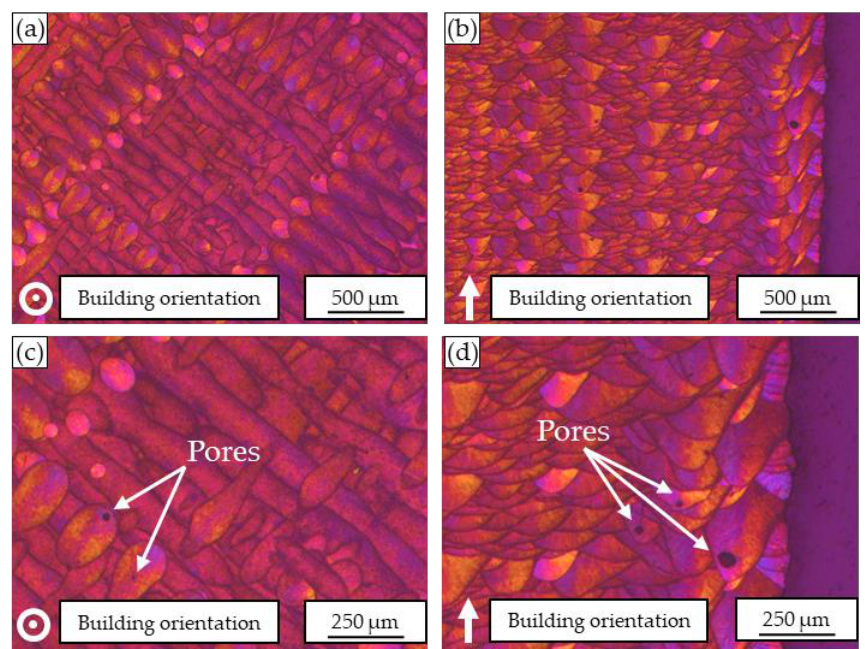
Figure 2. Barker etched microstructure of the horizontal 0° specimen: ( a ) and ( c ): top view and corresponding magnification; ( b ) and ( d ): side view and corresponding magnification.